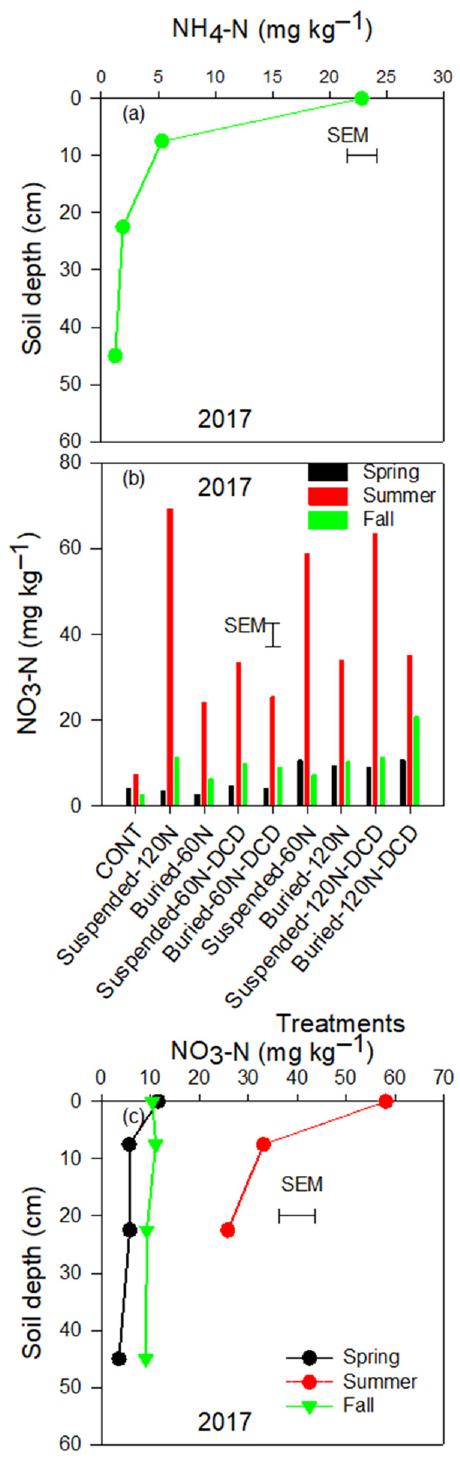
Figure 3. Concentrations of ( a ) ammonium nitrogen (NH 4 + -N, mg kg − 1 ) and ( b , c ) nitrate nitrogen (NO 3 − -N, mg kg − 1 ) among treatment combinations and soil depth with annual applications of combination of nitrogen fertilizer rates and nitrification inhibitors (2-chloro-6-(trichloromethyl)-pyridine (Nitra-pyrin), di-cycandiamide (DCD)) in soils collected in a long-term blueberry experiment during the growing season (spring, summer, fall) in 2017 (N = 396). In 2018, the concentration of NH 4 + -N was influenced by soil depth and the extent varied with the seasons ( p = 0.001, Depth × Season interaction) (Table 3). In the spring, the concentration of NH 4 + -N was 7.5 mg kg –1 in the layer of sawdust mulch and increased to 13.1 mg kg –1 at depth 0–15 cm and 15–30 cm, but remained low (5.3 mg kg –1 ) and similar to the sawdust layer at depth 30–60 cm (Figure 4a). In the summer the concentration of NH 4 + -N varied between 7.4 mg kg –1 in the layer of sawdust mulch and in the 0–15 cm soil depth to 3.6 mg kg –1 (Figure 4a). In the fall, the concentration of NH 4+ -N was 7.9 mg kg –1 in the layer of sawdust mulch and remained low at average concentration of 2.2 mg kg –1 at depths 0–15 cm, 15–30 cm and 30–60 cm (Figure 4a). In contrast to NH 4+ -N, the concen- tration of NO 3 − -N was influenced by the treatment combinations, the soil depths and the seasons ( p < 0.001, Treatment × Depth × Season) (Table 3). In the spring, the concentration